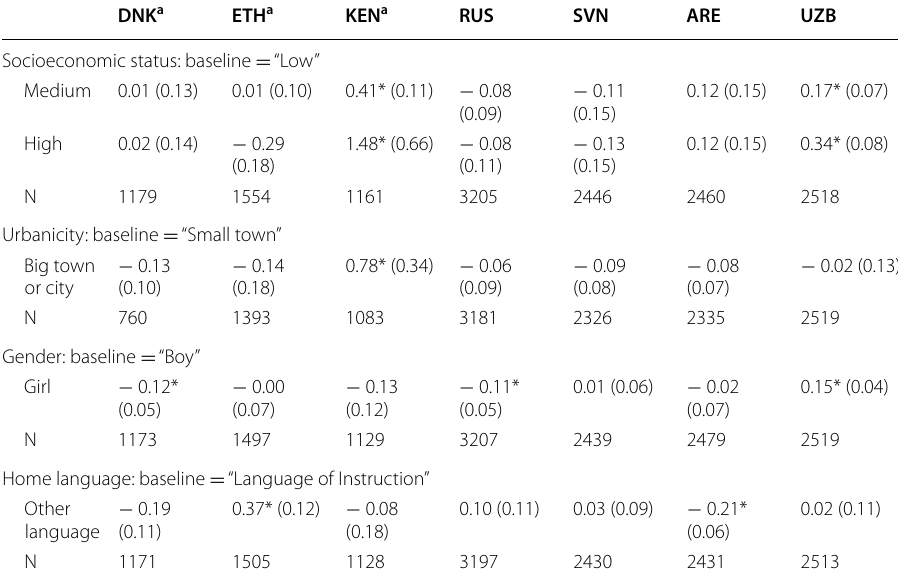
Coefficients for groups come from separate regressions. Standard errors shown in parentheses. Probability weights have been applied and jackknife standard errors have been calculated in all countries except in Denmark, Ethiopia, and Kenya. In Denmark, Ethiopia, and Kenya standard errors have been clustered by school DNK Denmark, ETH Ethiopia, KEN Kenya, RUS Russian Federation, SVN Slovenia, ARE United Arab Emirates, UZB = = = = = = Uzbekistan = a Data may not be representative of target population *p <